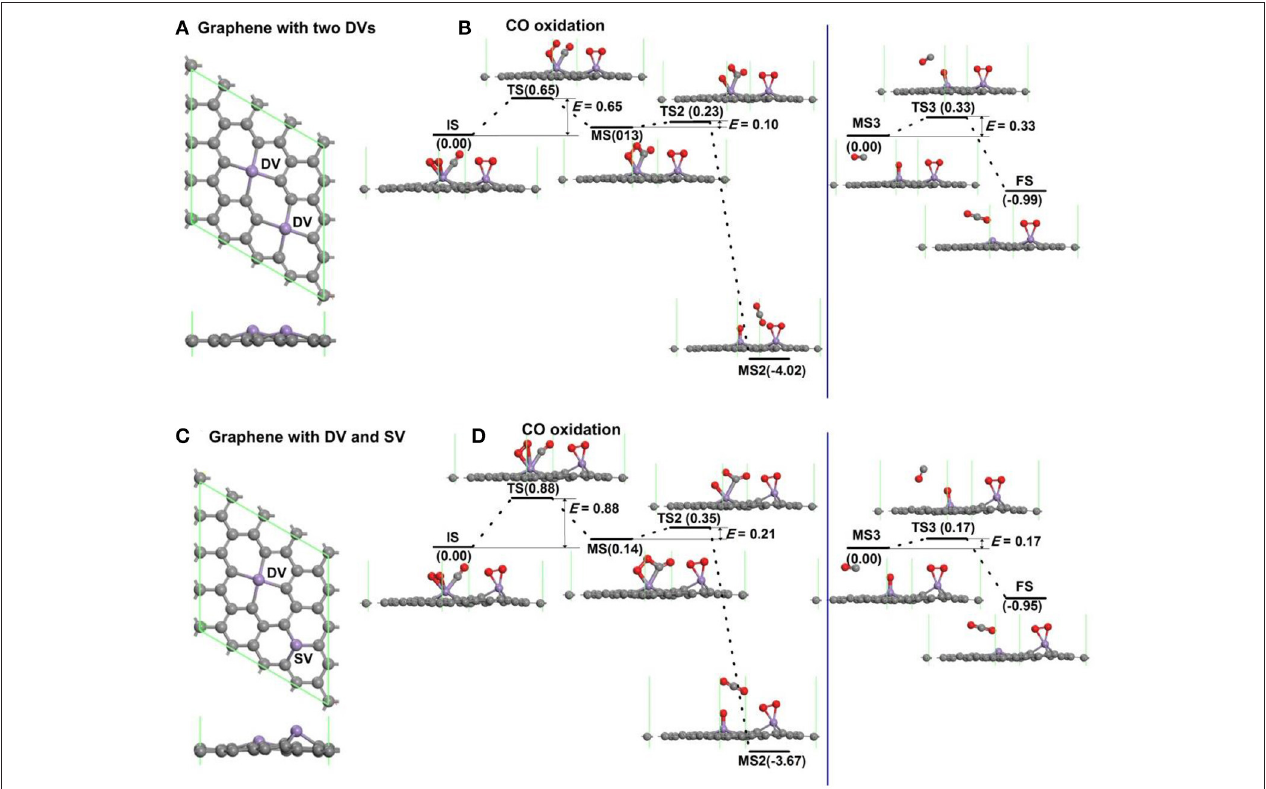
FIGURE 7 | The atomic structure of graphene with two divacancies embedded with Mn atoms (A) , and the corresponding reaction pathway of CO oxidation along LH mechanism (B) . The atomic structure of graphene with one divacancy and one single vacancy embedded with Mn atoms (C) , and the corresponding reaction pathway of CO oxidation along LH mechanism (D)